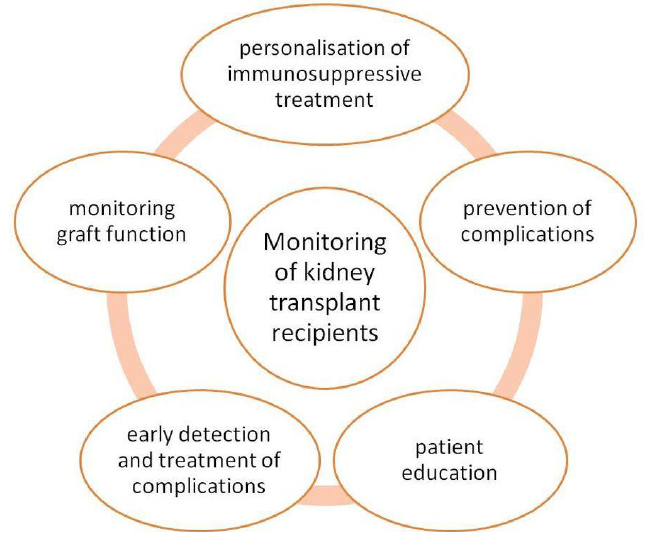
Figure 4. Aspects of transplant recipients monitoring.